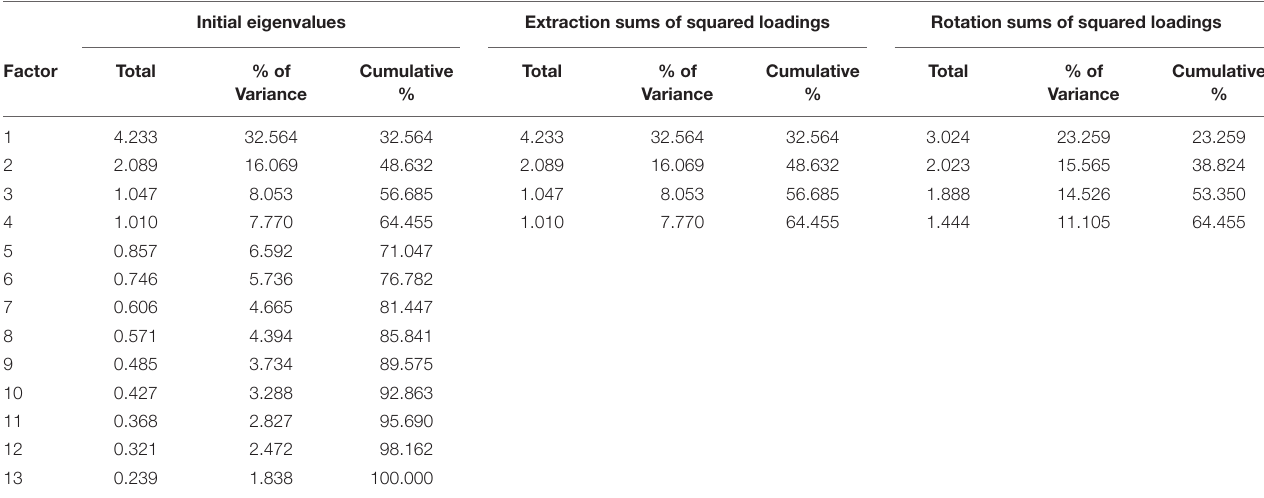
TABLE 3 | Principal component analysis with extraction sums of squared loadings and rotation sums of squared loadings (Varimax). Initial eigenvalues Extraction sums of squared